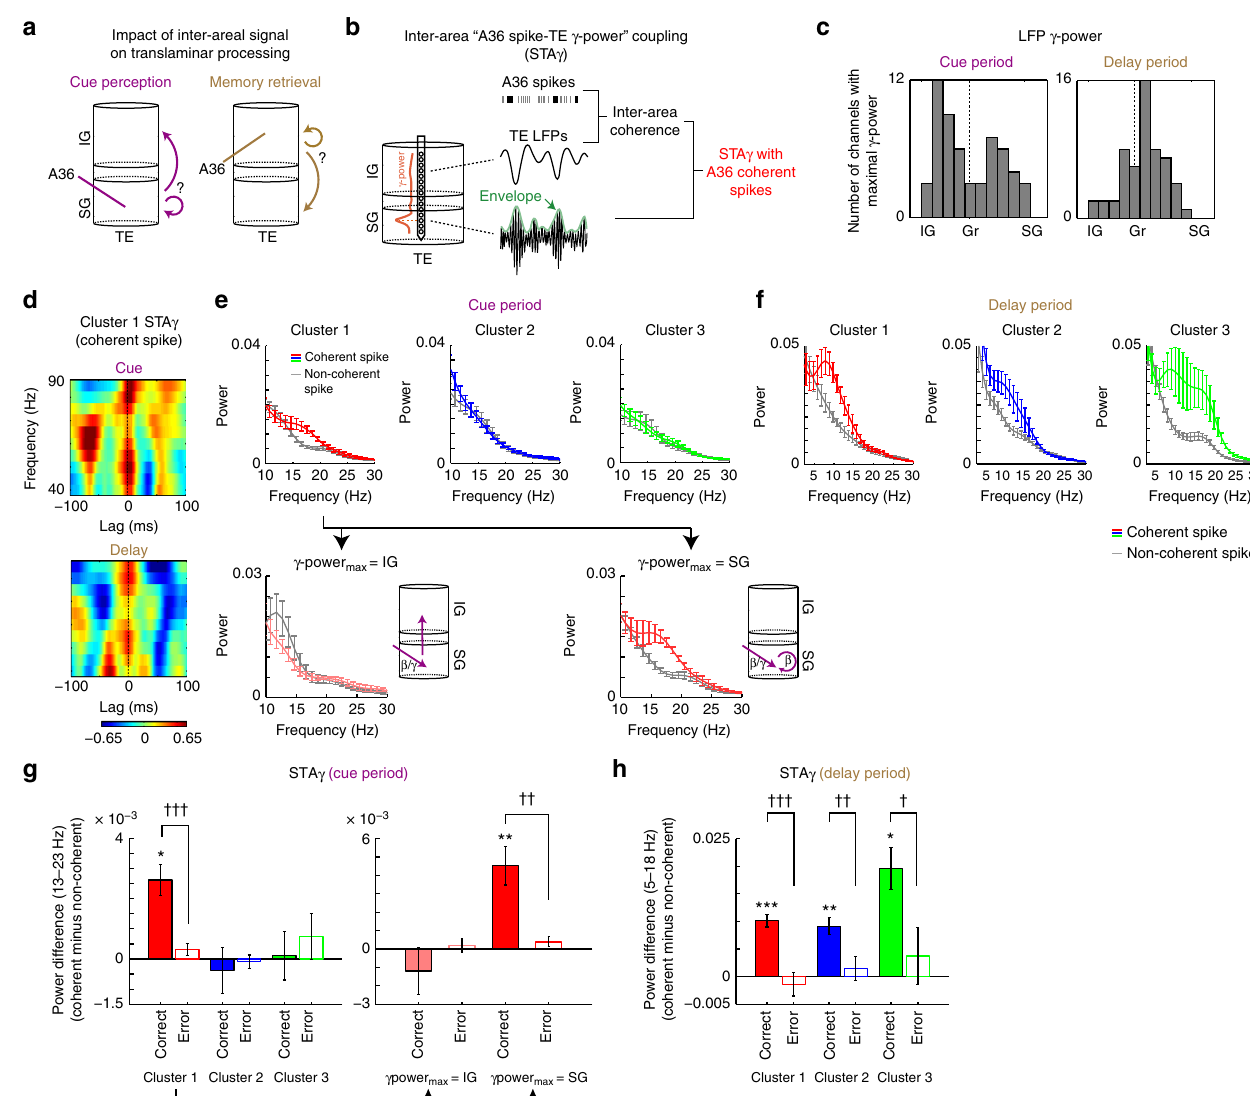
Fig. 4 Impact of inter-areal coherence on inter-laminar signal processing in TE. a Schematics for cascades of inter-areal and inter-laminar signal processing. b Diagram of spike-triggered average (STA) of the γ -power (STA γ ). A36 spikes that were coherent with TE local fi eld potentials (LFPs) at the channel showing maximum coherence were fi rst extracted (shown in black ticks) from all spike trains. Then, a STA of γ activity envelope (green) was calculated. The γ activity envelope was selected at the TE channel showing maximum γ -power (in this example, in SG). See Methods for details. c Histograms of TE channels showing maximum γ -power. Gr granular layer. n = 56. See also Supplementary Figure 14. d Population STA γ with coherent spikes in cluster 1. e Power spectrum of STA γ (STA γ power) for each cluster (mean ± s.e.m.) during the cue period. STA γ power with coherent spikes and non-coherent spikes are shown separately. n = 19, 24, and 13 for clusters 1, 2, and 3, respectively. Bottom panels depict the STA γ power for datasets with maximum γ -power at infragranular layer (IG, left) and at the supragranular layer (SG, right). f The STA γ power for each cluster during the delay period. See also Supplementary Figure 15. g , h Error analysis of STA γ for each cluster during the cue period ( g ) and the delay period ( h ). Shown are the mean (±s.e.m.) values of difference in STA γ power between coherent and non-coherent spikes at the frequency range of 13 − 23 Hz (cue) and 5 − 18 Hz (delay). *, comparison with zero (*, P < 0.05; **, P < 0.01; ***, P < 0.001; paired t -test corrected for multiple comparisons). † , t -test corrected for multiple comparisons ( † , P < 0.05, †† , P < 0.01, ††† , P < 0.001). Note that the number of correct trials was reduced to be matched with that of error trials (see Figure 4d depicts a population STA γ with coherent spikes in amplitude of STA γ power depended on the cortical layer of the cluster 1, which showed a low-frequency periodic increase in γ - maximum γ -power: the STA γ power for coherent spikes was power during both the cue and delay periods. We examined the greater than that for non-coherent spikes only in datasets spectral properties of the STA γ for datasets in each cluster showing the maximum γ -power in SG, but not in IG. In contrast, separately (Fig. 4e, f). During the cue period, the population STA γ during the delay period, all clusters showed increased STA γ (STA γ power) with coherent spikes in cluster 1 was greater than power at the 5 − 18 Hz ( α ) frequency range (in cluster 3, the that calculated with non-coherent spikes, speci fi cally in the low- frequency of increase in STA γ power extended to about 25 Hz; frequency range (13 − 23 Hz, β ), whereas no difference in STA γ Fig. 4f). The increase in STA γ power during the delay period power between coherent and non-coherent spikes was observed predominantly emerged when the SG channel showed the in clusters 2 and 3 (Fig. 4e). Interestingly, in cluster 1, the maximum γ -power (Supplementary Fig. 15).